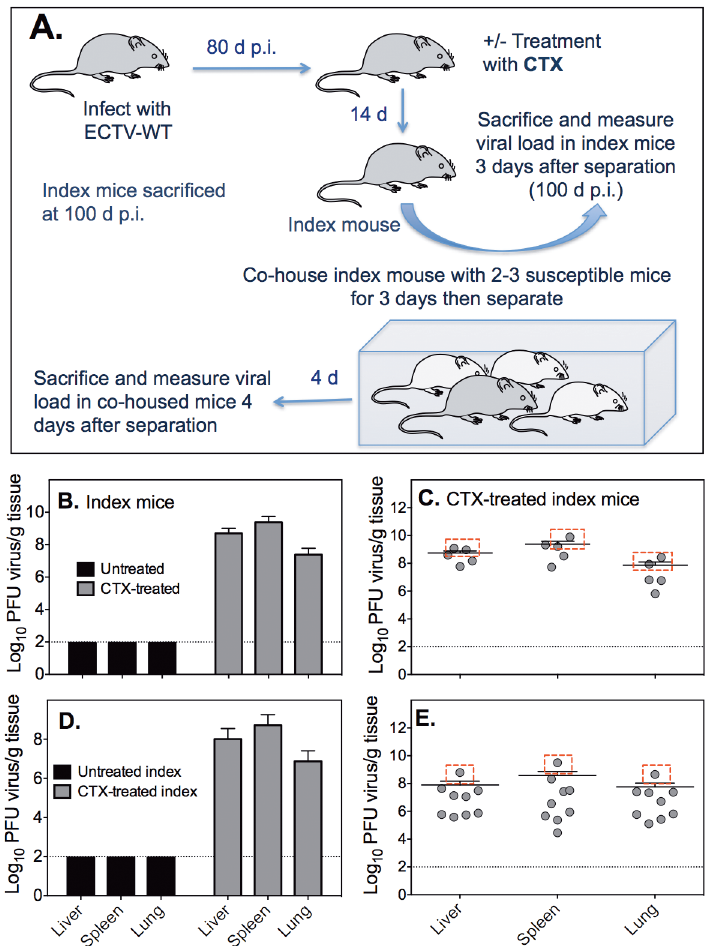
days and treated with CTX or left untreated. (B) ECTV-WT titers in organs of untreated or CTX-treated index mice at 21 days post-commencement of treatment (101 days p.i.). (C) Viral load in organs of individual CTX- treated mice at 101 days p.i. (D) ECTV-WT titers in organs of na ï ve mice co-housed with untreated or CTX- treated mice. (E) Viral load in organs of individual na ï ve mice 4 days post-separation from index mice. For C and E, the boxed data shows viral load in organs of mice that succumbed to